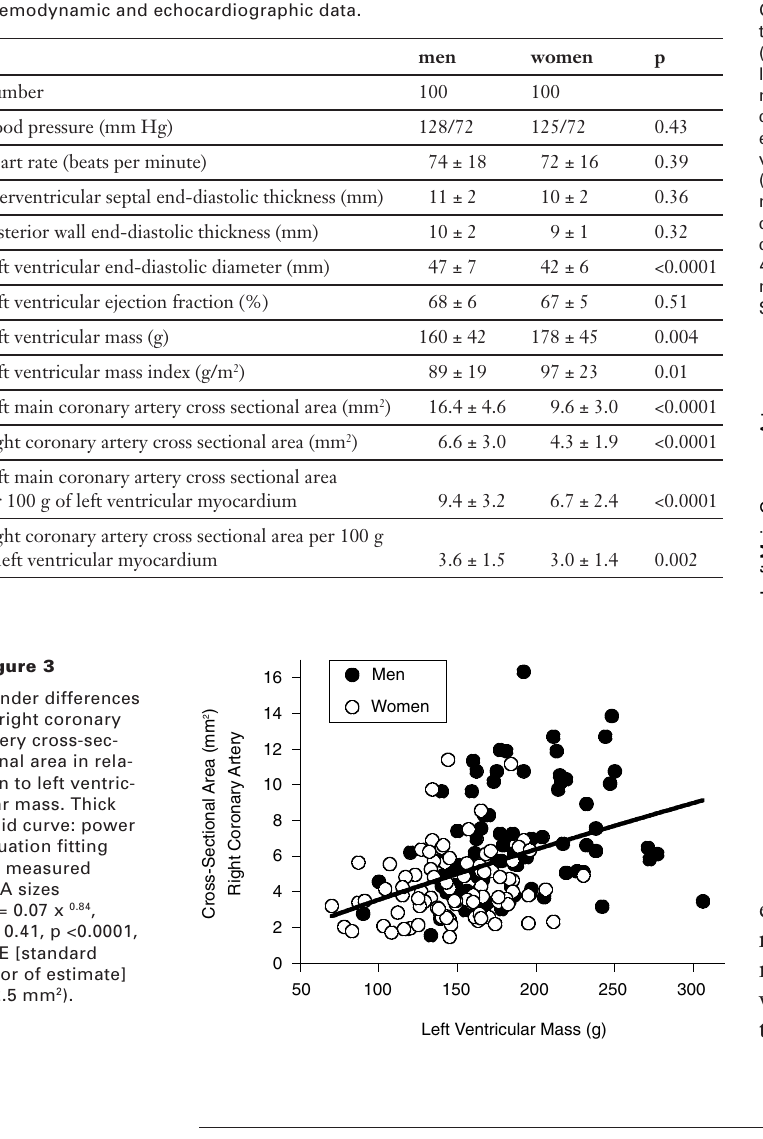
Haemodynamic and echocardiographic data.